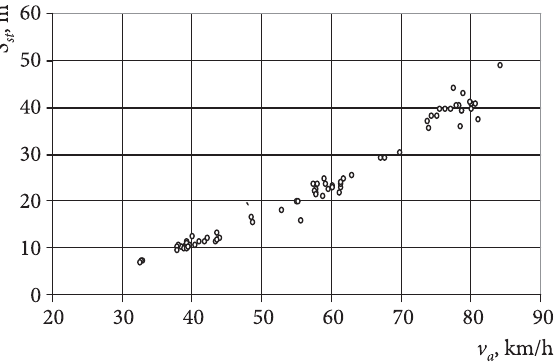
values for cars st